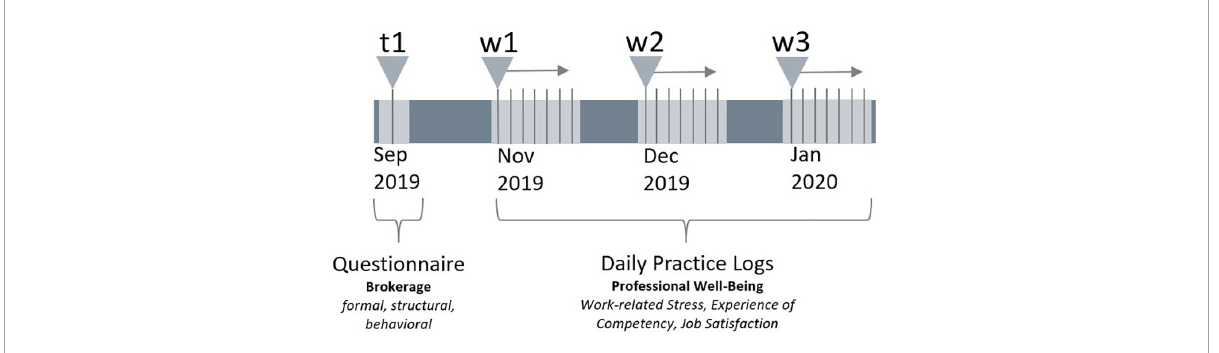
FIGURE1 Illustration of the data collection for both the online questionnaire at the beginning of the school year 2019/20 and the three waves in which daily practice logs were collected.